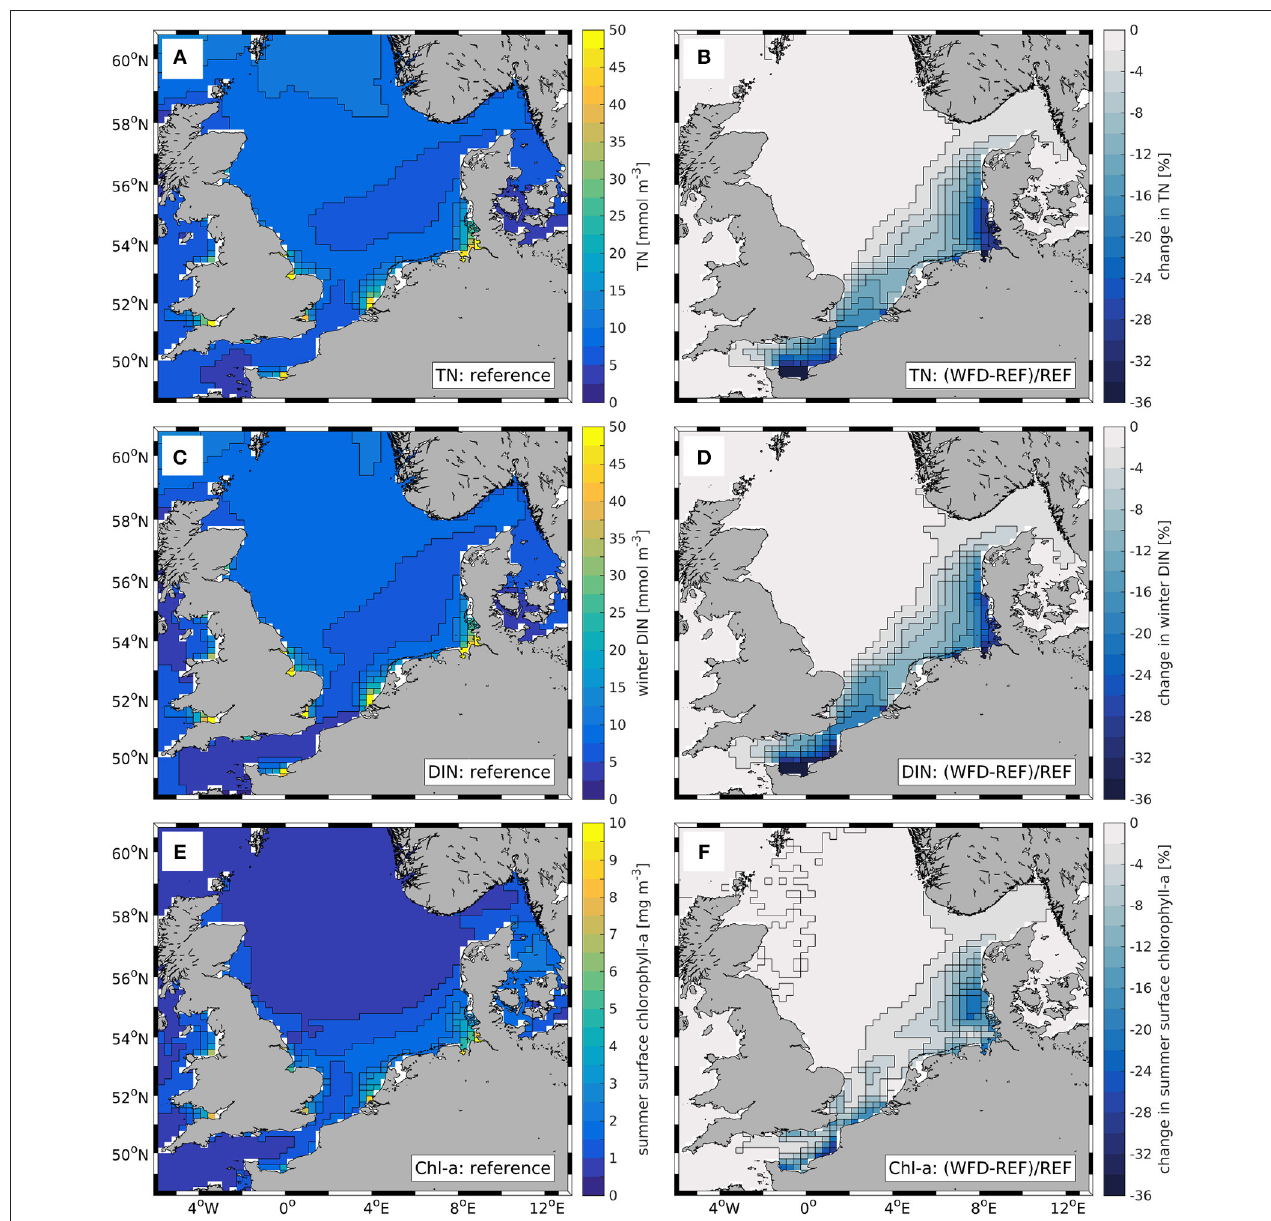
FIGURE 3 | Maps of (left) concentrations of selected OSPAR assessment parameters simulated by reference simulation (“REF”) and (right) relative change between reference simulation and WFD reduction scenario (“WFD”) during 2006–2014: (A,B) annually and water column averaged TN, (C,D) winter (January/February) water column averaged DIN, and (E,F) growing season (March–September) surface chlorophyll-a. Relative change is calculated as (“WFD” − “REF”)/“REF” using the average values of “REF” and